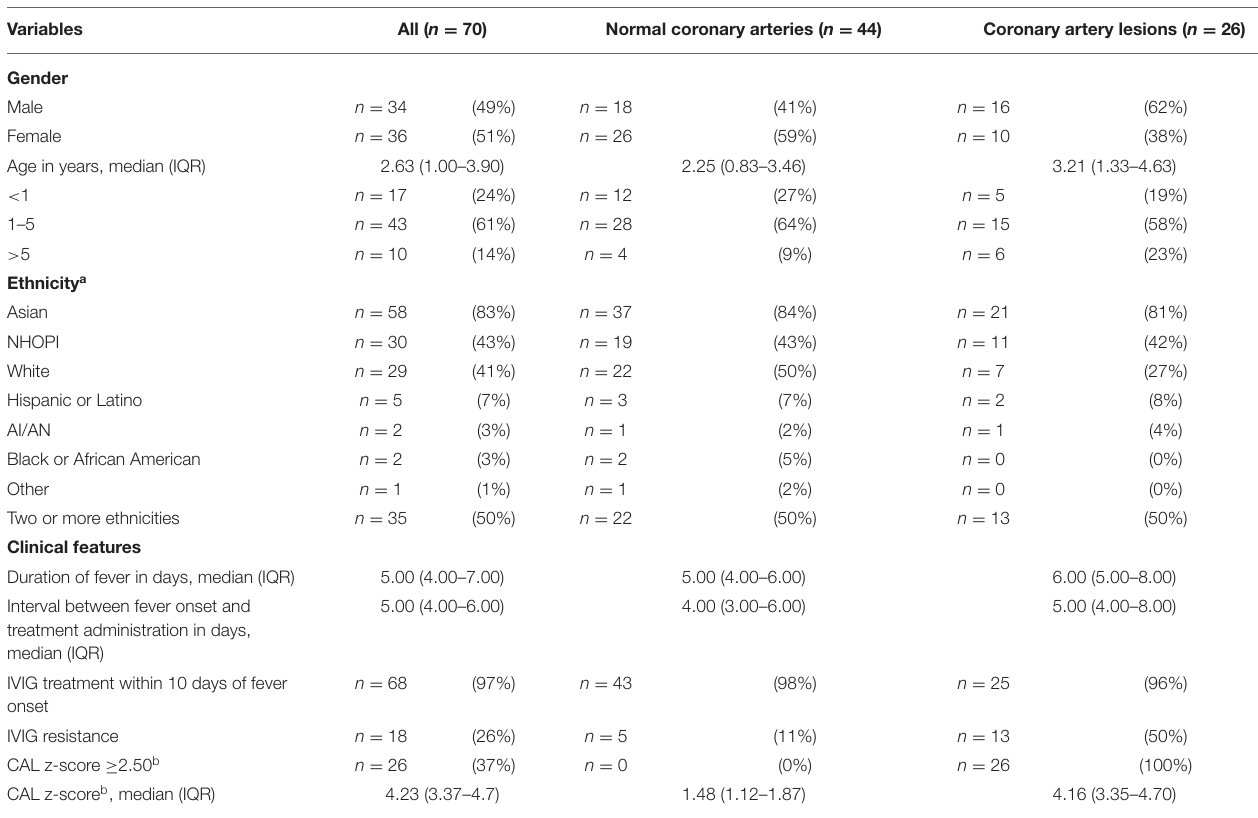
TABLE 1 | Patients’ clinicoepidemiological characteristics.